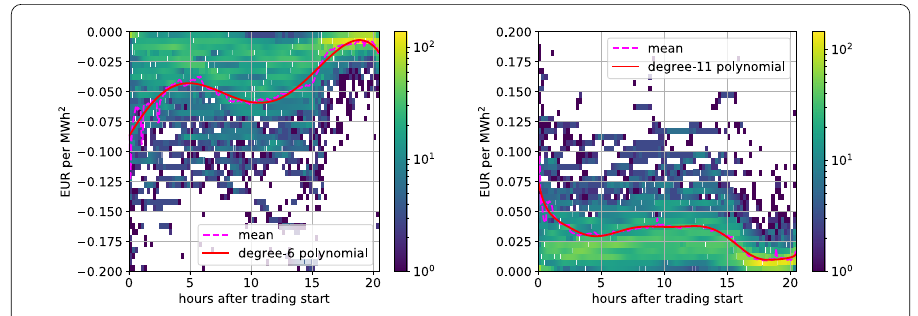
Figure 4 Histogram of the relation between market order volume and execution costs applying a linear model, dividing the time into 15-minute intervals and the coefficients into intervals of 0.002 e /MWh